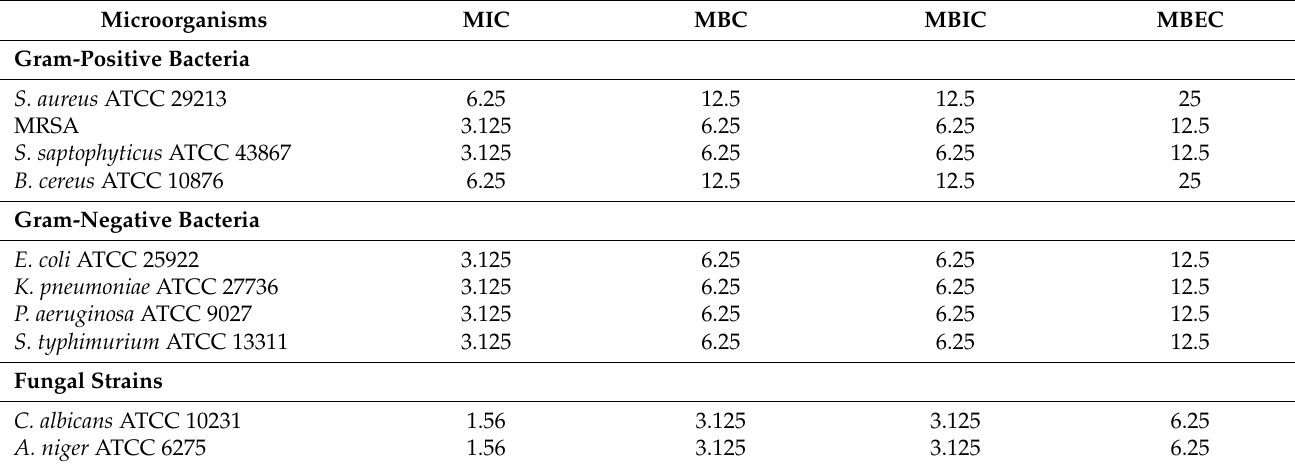
Table 2. MIC, MBC, MBIC, and MBEC of